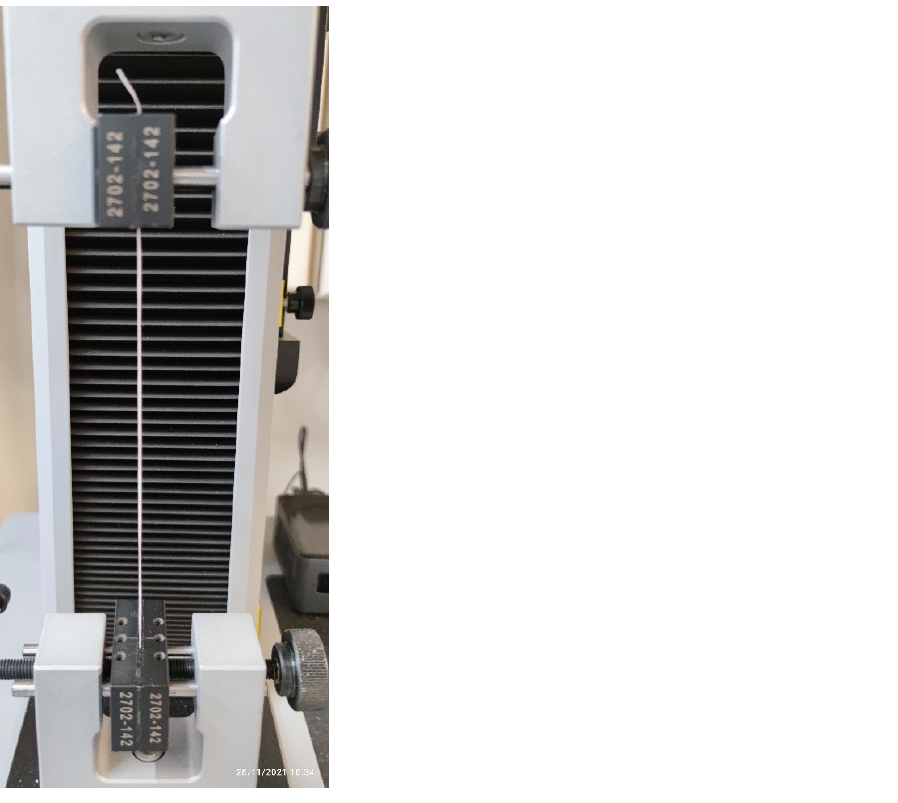
Figure 2. A dental floss sample loaded onto the tension testing system. The bottom part is fixed and the top part connected to a force transducer, and movable. In this case, straight, rubberized fixtures were used to avoid floss slippage.